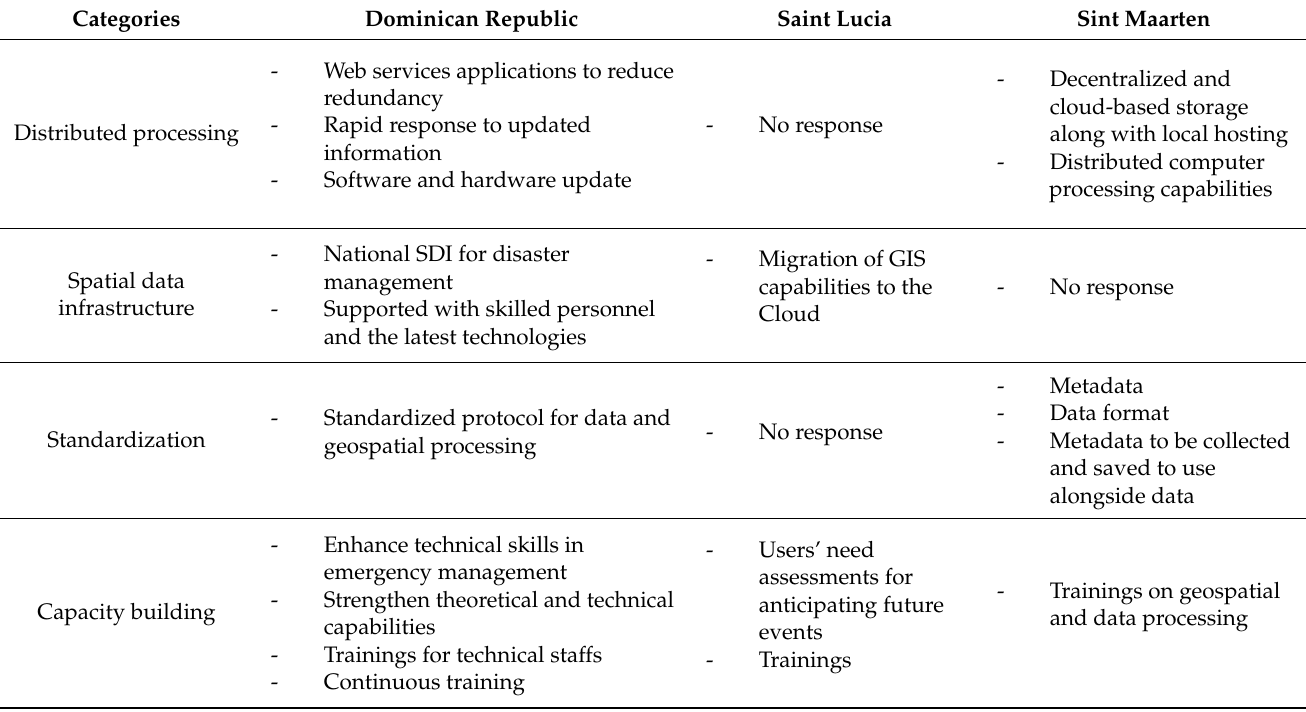
Table A3. Recommendations for EMT geospatial and data processing